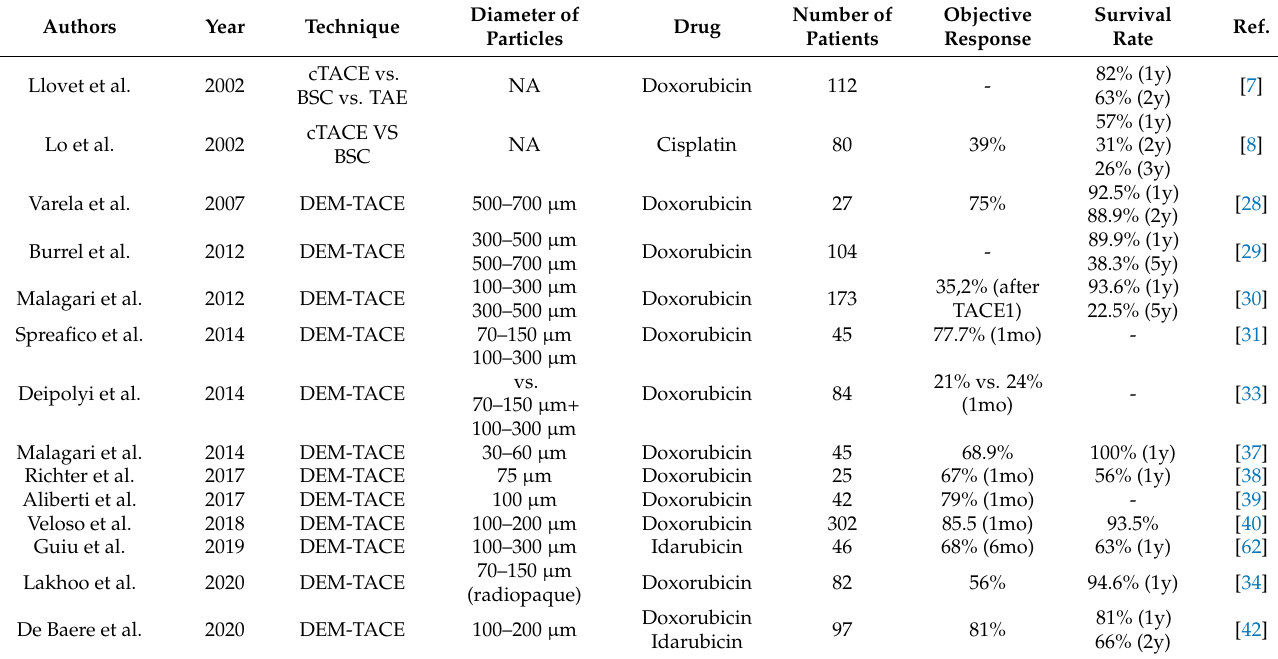
Table 1. Results in terms of efficacy of major studies on conventional and drug-eluting transarterial chemoembolization of